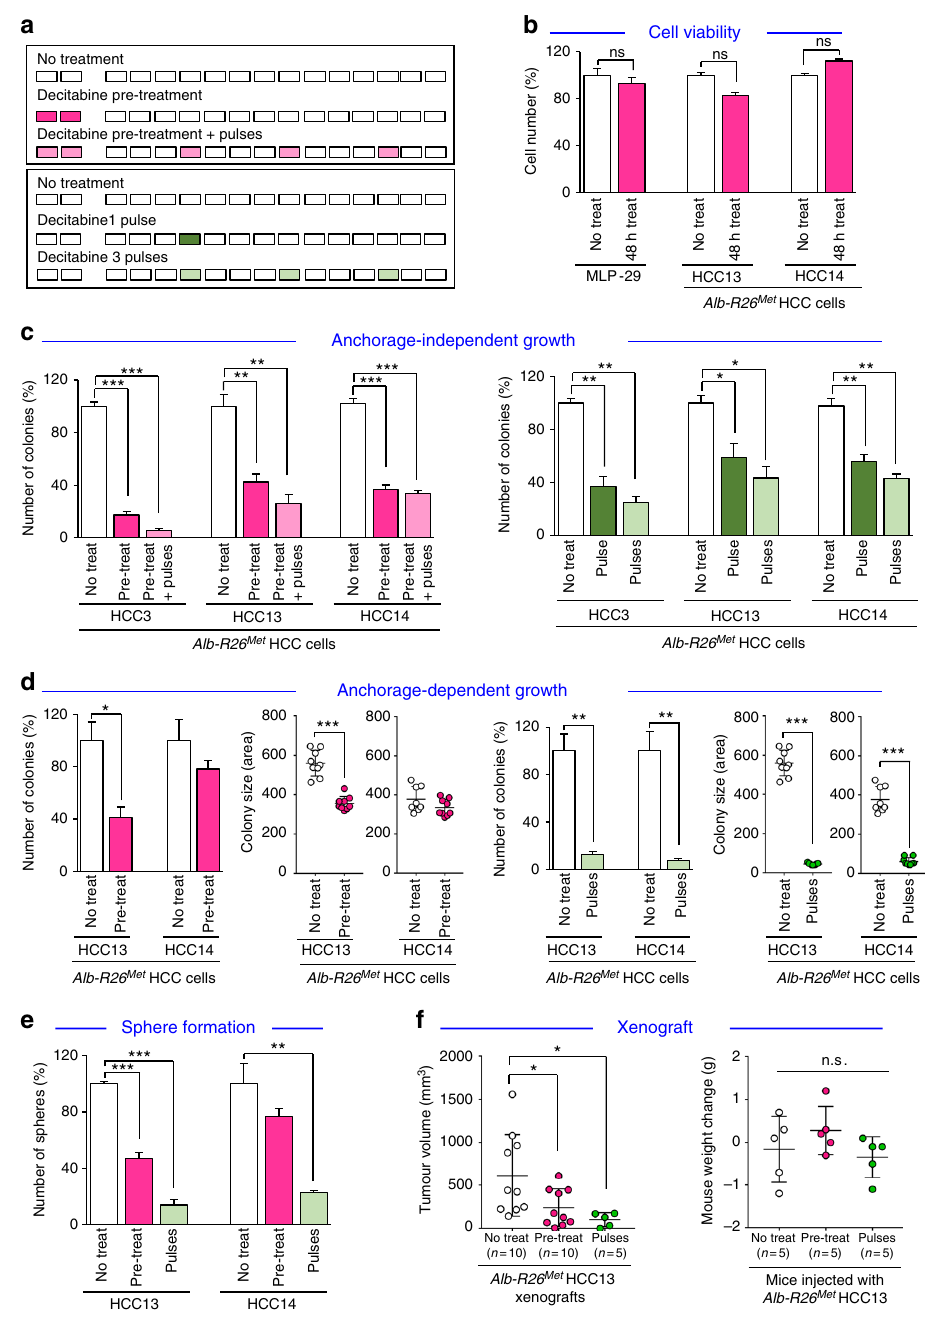
Fig. 2 Global CGI hypermethylation is functionally relevant for Alb-R26 Met tumorigenesis. a Scheme reporting demethylating treatments (Decitabine; 0.3 μ M) used for in vitro and in vivo experiments with Alb-R26 Met HCC cells. Cells were pre-treated (48 h) before using them for experiments with